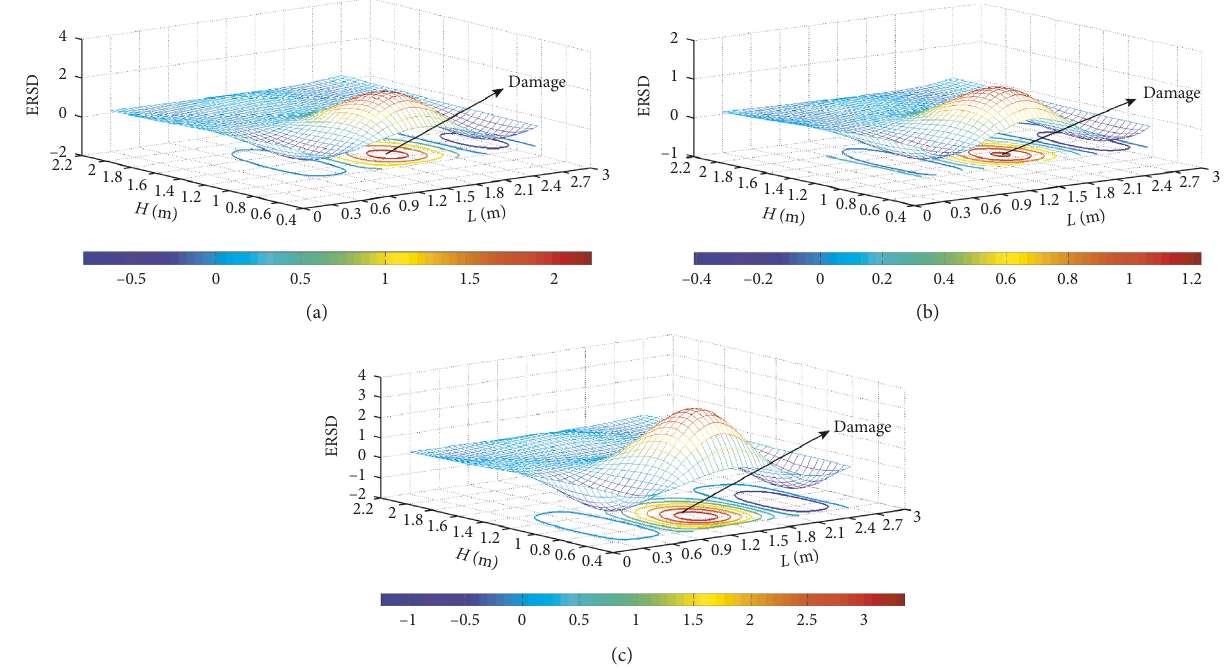
Figure 11: Trend surface of ERSD in model tests (single damage). (a) Case 3. (b) Case 6. (c) Case 8.